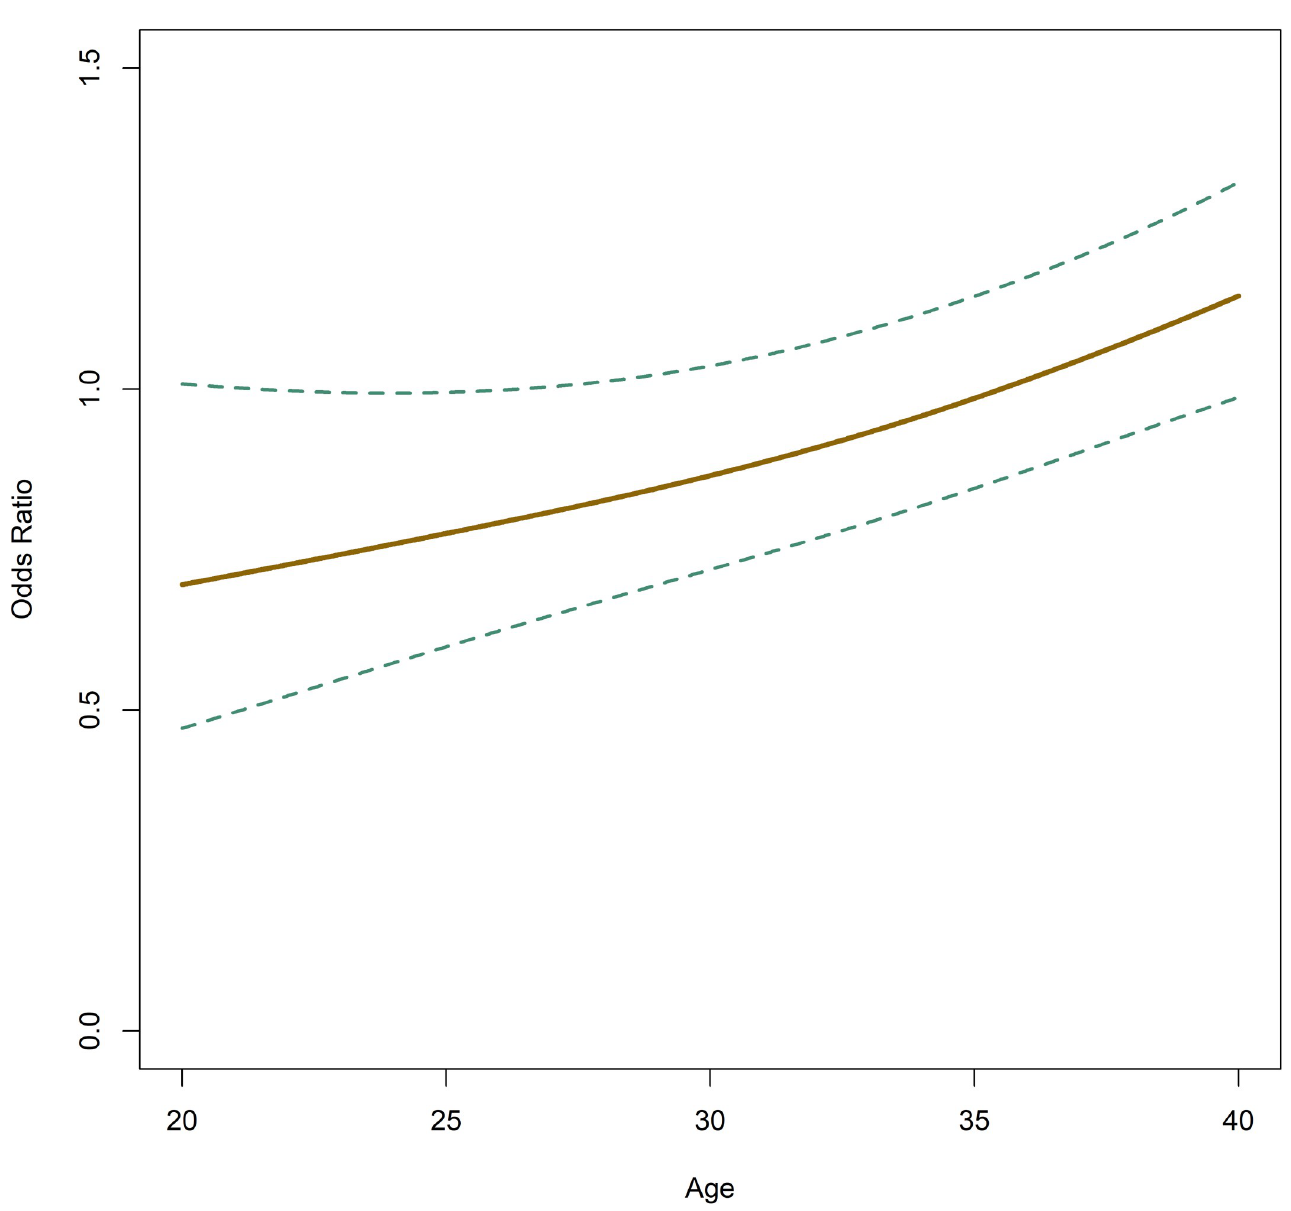
Fig 6. Odds ratio regarding nucleation error occurrence relative to patient age. Dashed lines show the 95% confidence intervals (CI). https://doi.org/10.1371/journal.pone.0274502.g006 Table 5. Association between insemination type and live birth, nucleation error occurrence, short second cell cycle (t3—t2 < 9.33 h) and long second cell cycle (t3— t2 > 12.65). Outcome Insemination